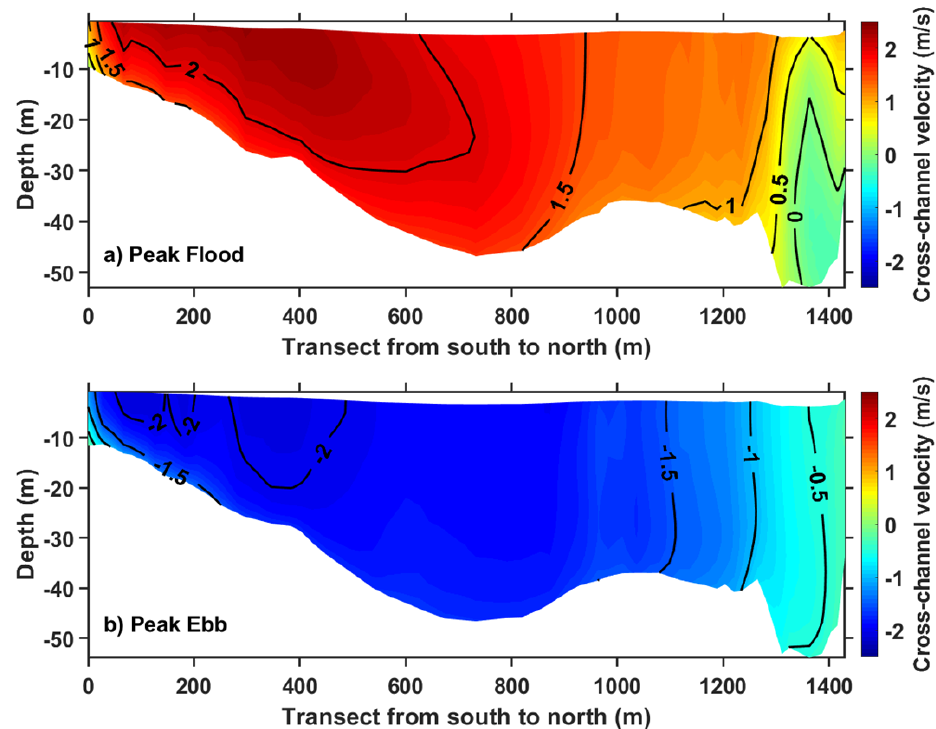
Figure 10. Normal velocity magnitudes at ( a ) peak flood and ( b ) peak ebb tides along cross section XS2 in the Western Passage. Positive velocity is away from the reader. The cross-section location is shown in Figure 1.